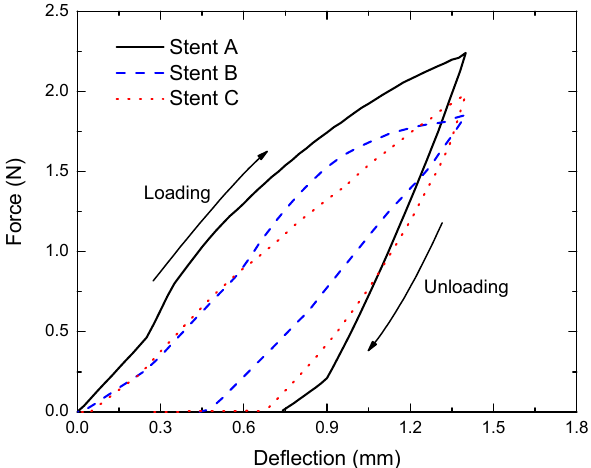
Figure 21. Three-point bending force-deflection curves of the three stents.